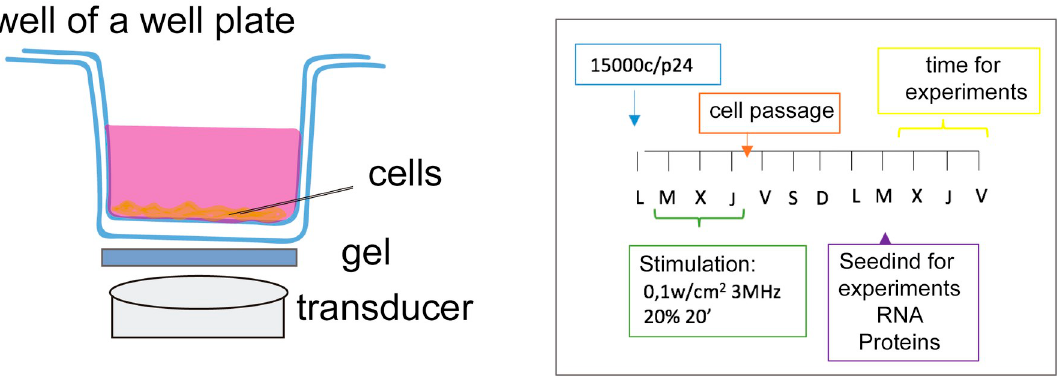
Fig 1. Scheme of the ultrasound application and the experimental design. The application of LIPUS was performed with a gel between the transducer and the bottom of the plate where the cells are attached. The experiments were conducted 5 days after the final application of LIPUS. Ultrasound attenuation within a polystyrene standard culture plate (1.2 mm) has been described as not significant (less than 0.3 dB or 4% over the frequency range from 1 to 3 MHz)